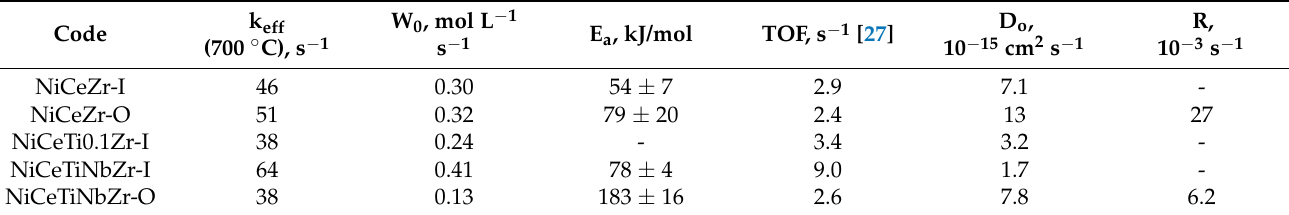
Table 4. Kinetic parameters for investigated